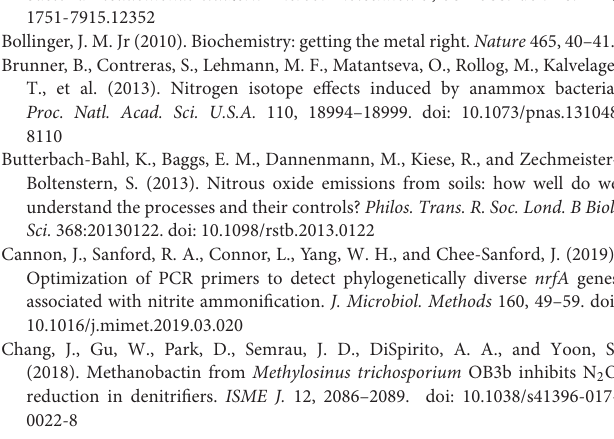
FIGURE S1 | Average eub gene copies g − 1 sediment (dry weight) at the end of incubation (96 h) in microcosms amended with molybdate (Mo), iron (Fe), copper (Cu), and combinations thereof. Letters above each bar graph indicate significant differences as determined by Kruskal–Wallis and Bonferroni post hoc testing. TABLE S1 | Growth (OD 600 ) and headspace N 2 O (ppm) at 24 h for Paracoccus denitrificans incubated at different metal levels, under denitrifying conditions,